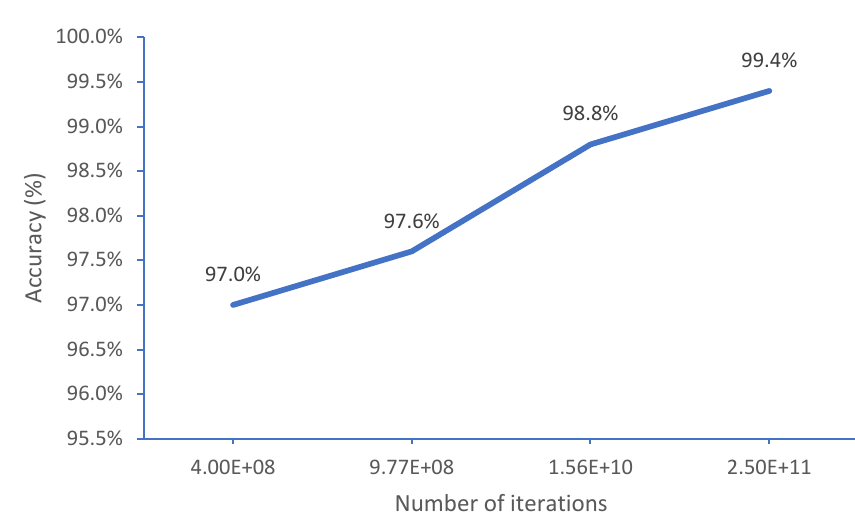
Figure 6. Accuracy versus the number of iterations for a = 2 m, b = 1 m and c = 2 m and Φ = 120 ◦ . Table 3. View factor simulation parameters at various element sizes.